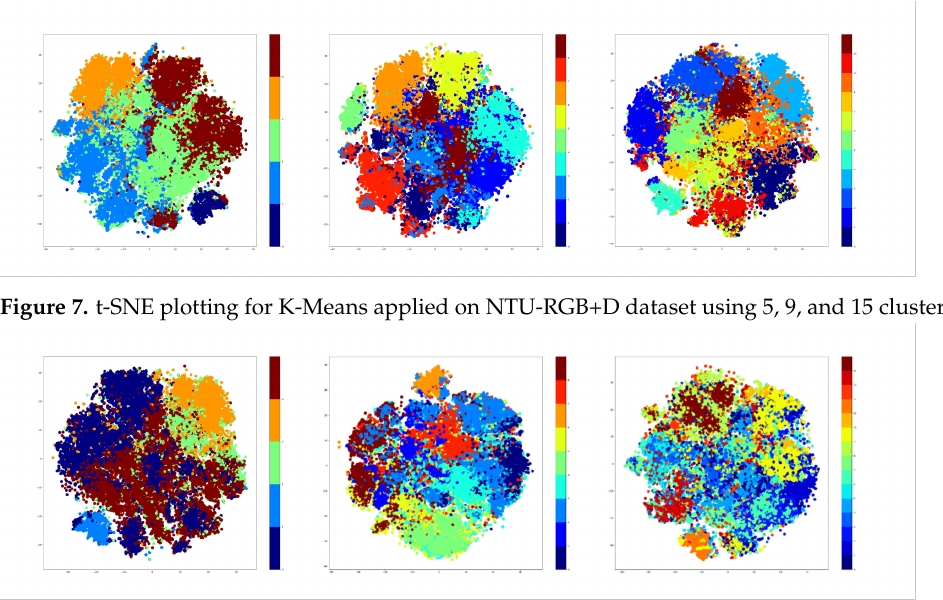
Figure 8. t-SNE plotting for GMM for NTU-RGB+D dataset using 5, 9, and 15 cluster.